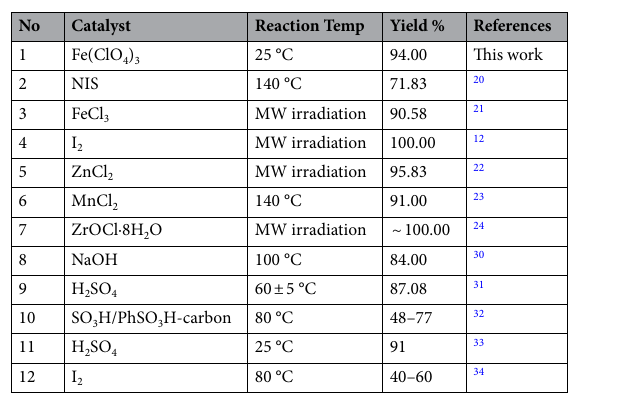
No Catalyst Reaction Temp Yield